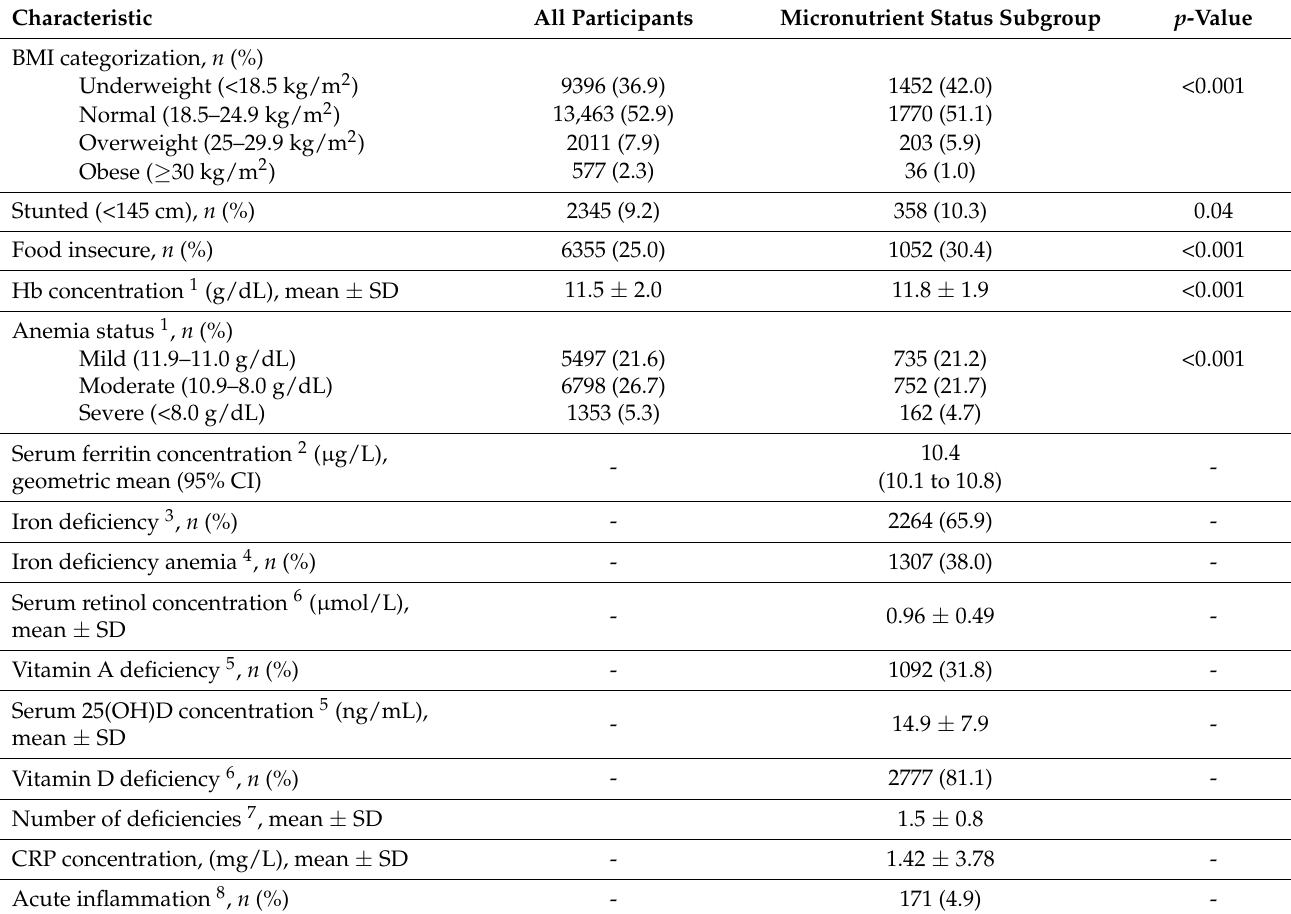
Table 2. Nutritional-status-related characteristics among participants at enrolment in the MaPPS Trial ( n = 25,447) and micronutrient status subgroup ( n =